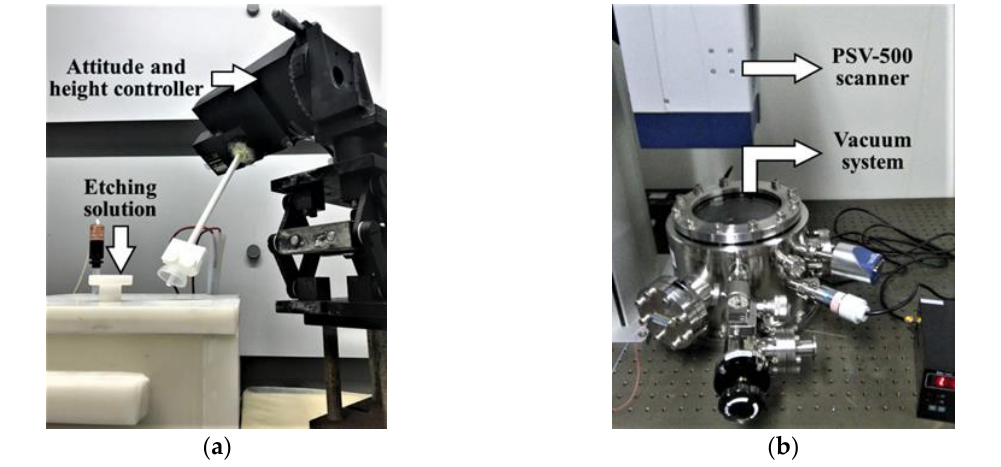
Figure 6. Experimental setup. ( a ) Etching system; ( b ) Measurement System .